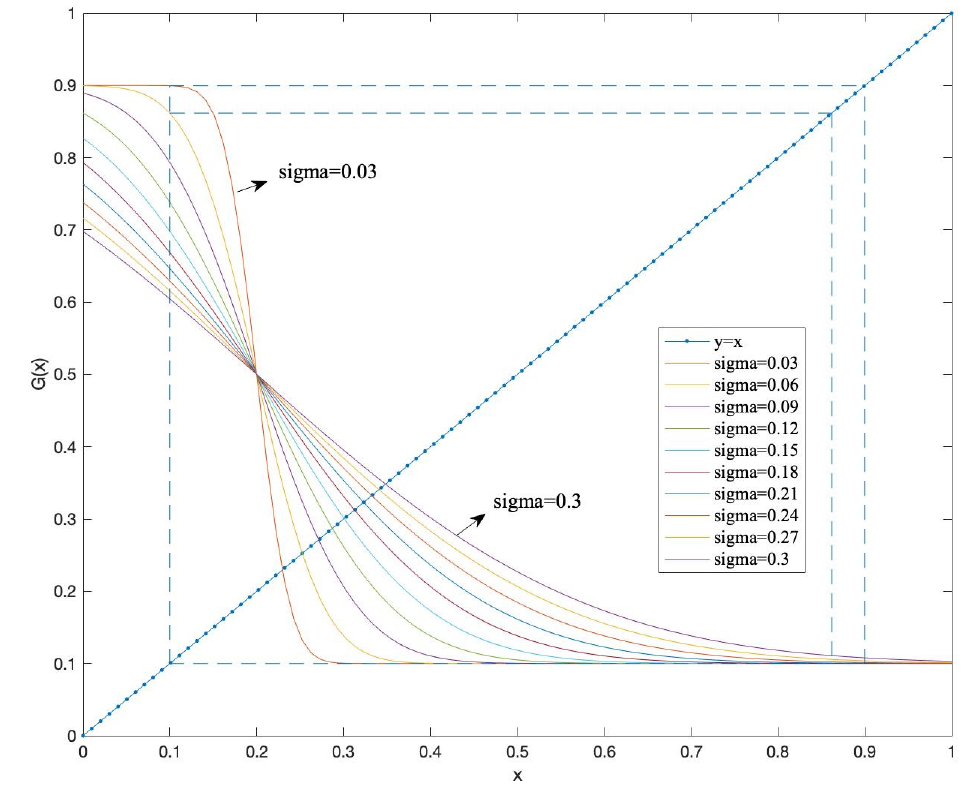
Figure 2. Gaussian distribution with a large proportion of anti-conformist agents ( q = 0.1), m =